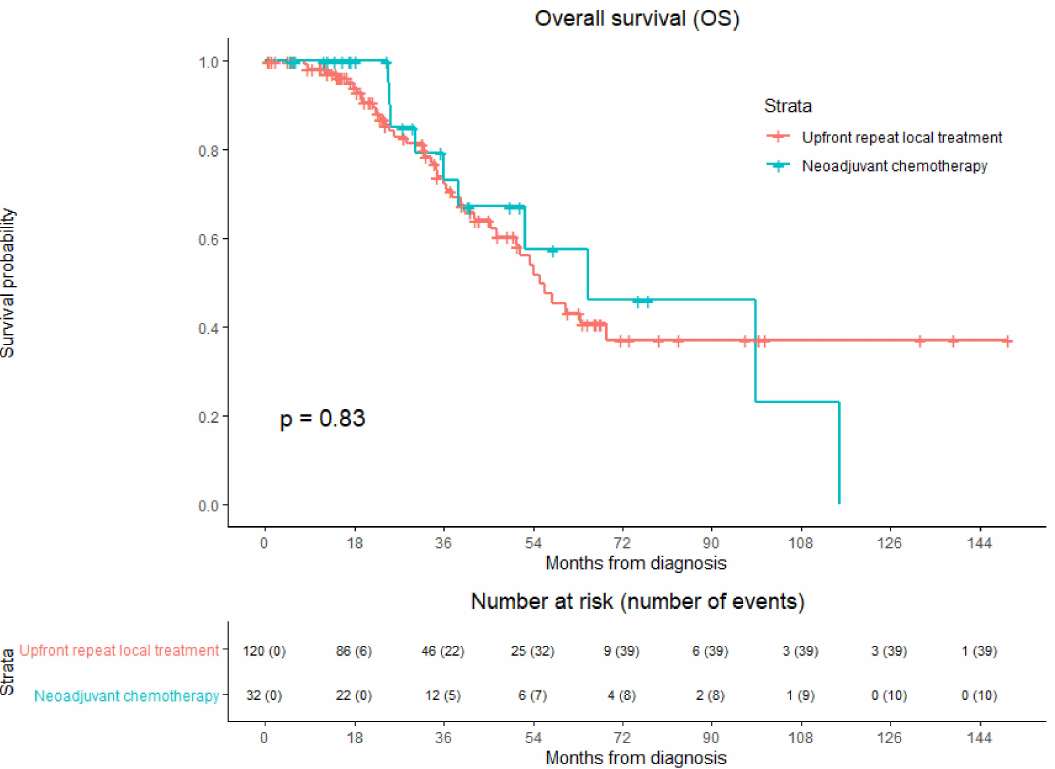
Figure 4. Kaplan–Meier curves of overall survival (OS) after upfront repeat local treatment (red) and neoadjuvant chemother- apy followed by repeat local treatment (green). Numbers at risk (number of events) are per patient. Overall comparison log-rank (Mantel–Cox) test, p =